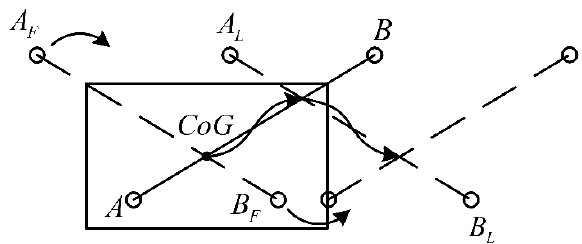
Appl. Sci. 2018 , 8 , x FOR PEER REVIEW Figure 17. Trajectory of the CoG in Test 2. Figure 16. Trajectory of the CoG in Test 2.